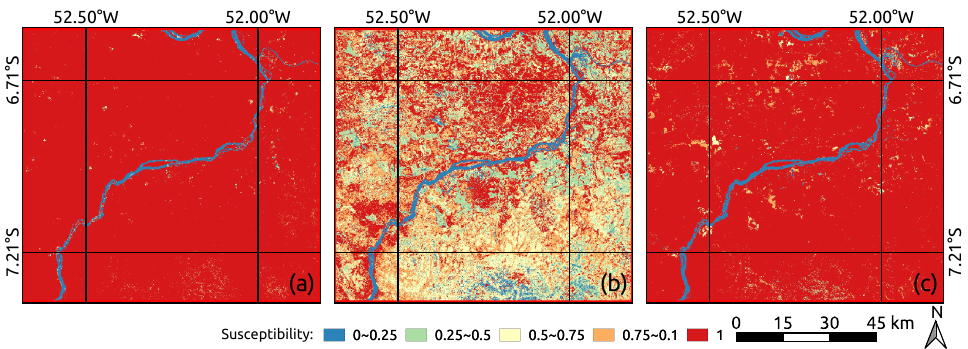
Figure 8. Fire susceptibility maps for Area 2 with IF method as anomaly detection model. Subfigures ( a – c ) refer to mappings based on the “analysis period” of epochs I, II, and III, respectively.